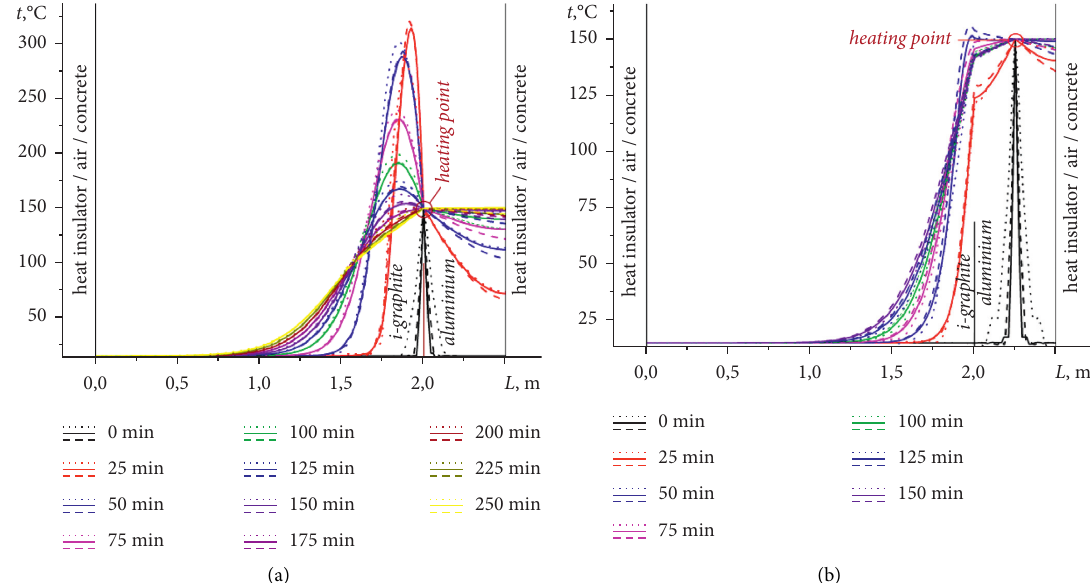
Figure 12: Dynamics of temperature fields in the irradiated graphite-aluminum system during heating in planes C (a) and D (b). Solid line: a heat insulator is located on the border of the region (adiabatic conditions); broken line: concrete is located on the border of the region; dotted line: there is air at the border of the